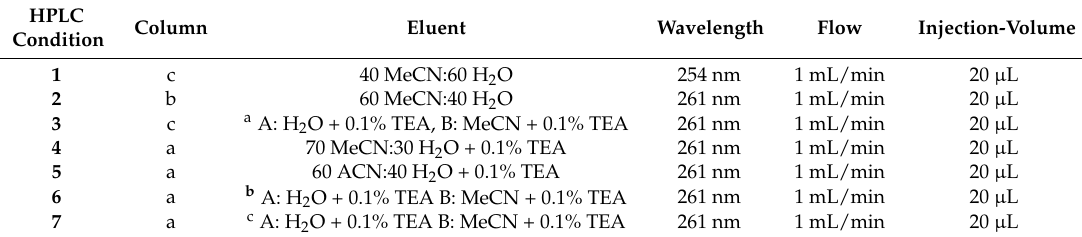
Table 1. Employed conditions of high performance liquid chromatography (HPLC) separations. HPLC Column Eluent Wavelength Flow Injection-Volume Condition 1